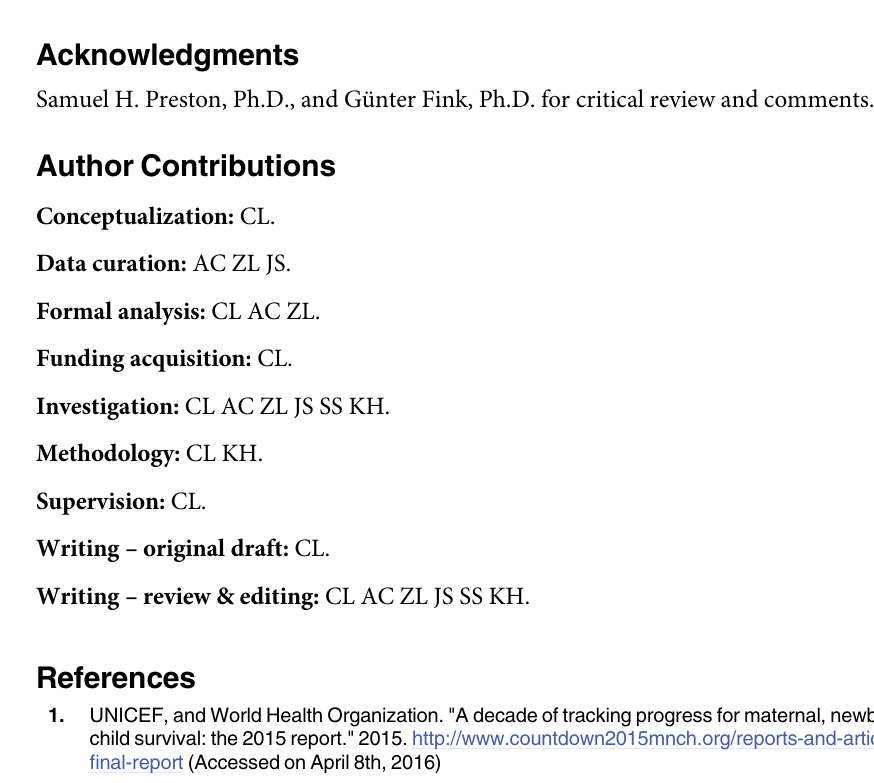
S11 Fig. Upper-bound estimates of aid disbursed to sectors for child survival in millions in 2013 USD by region, 2000–2014. S12 Fig. Upper-bound estimates of aid disbursed to sectors for child survival in millions in 2013 USD by income, 2000–2014. S13 Fig. Upper-bound estimates of aid disbursed to RMNCH, health_non-RMNCH, food, water and sanitation, humanitarian assistance, and education in billions in 2013 USD, Countdown vs. non-Countdown, 2000–2014. S14 Fig. Proportion of aid (upper-bound) for RMNCH in total health